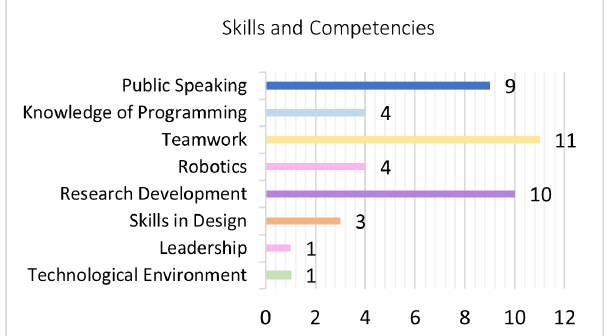
Figure 6. Skills and competencies acquired from the project.